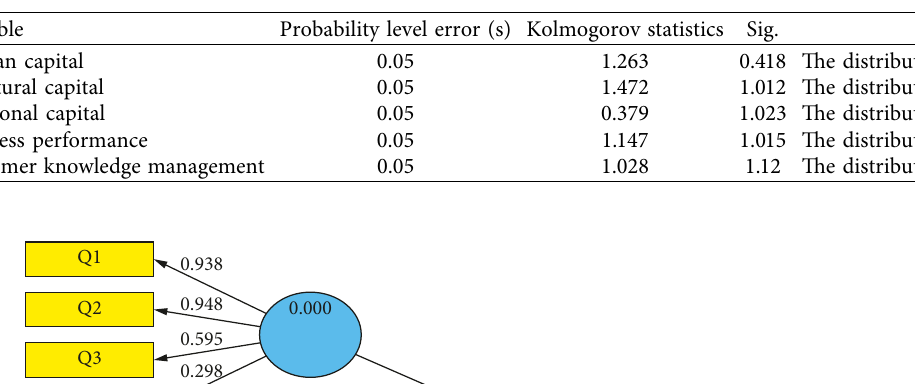
Table 2: The result of Kolmogorov statistics.